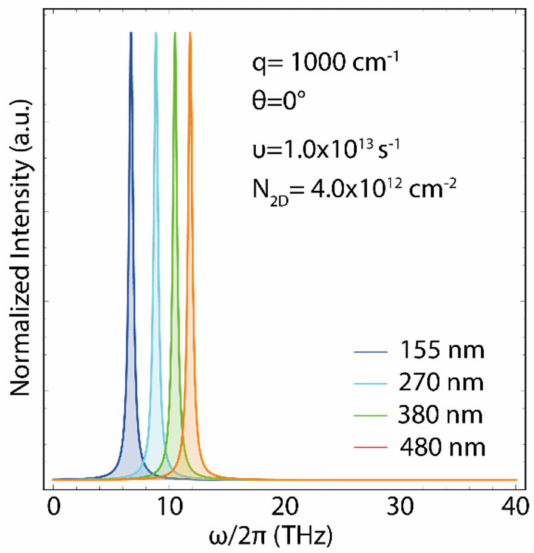
Figure 10. Maximum of the plasmon peak ( ≤ 40 THz) at q = 1000 cm − 1 and N 2 D = 4.0 × 10 12 cm − 2 .